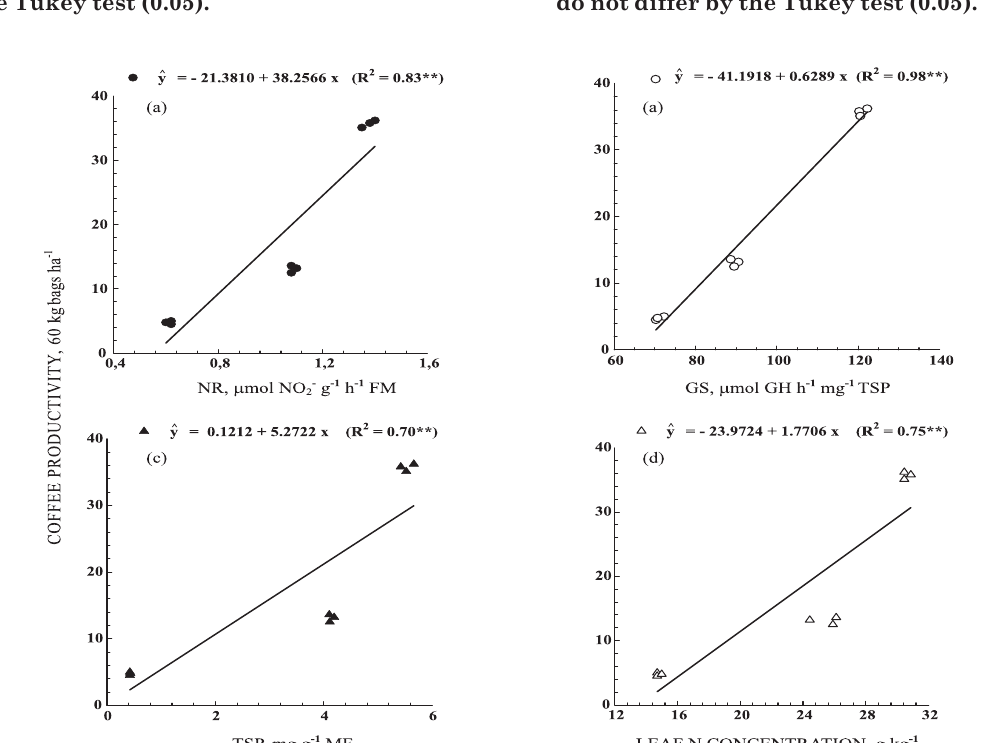
Figure 7. Relationships between: coffee yield and nitrate reductase activity (NR) (a); coffee yield and glutamine synthetase (GS) activity (b); coffee yield and leaf total soluble protein (TSP) (c), coffee yield and leaf N concentration (d), considering the period of March, the month of highest significant